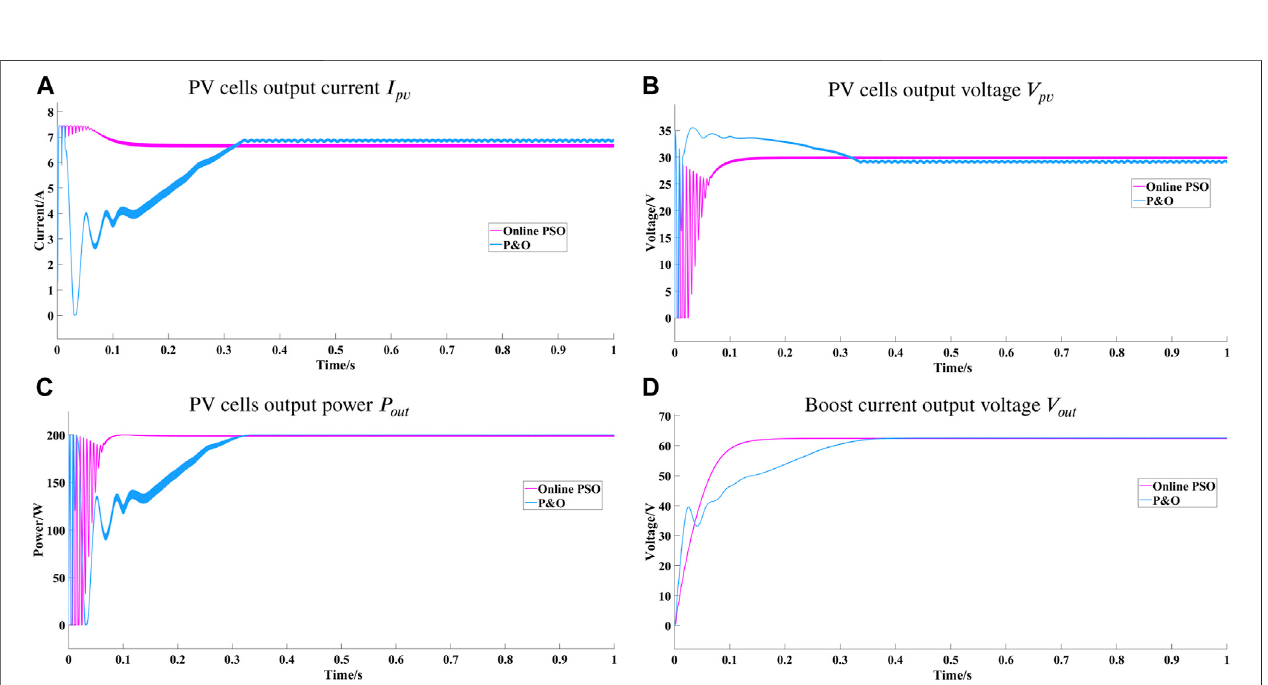
FIGURE 9 | Comparison of online PSO and P and O results under the standard conditions. (A) PV cells output current Ipv. (B) PV cells output voltage Vpv. (C) PV cells output power Pout. (D) Boost current output voltage Vout